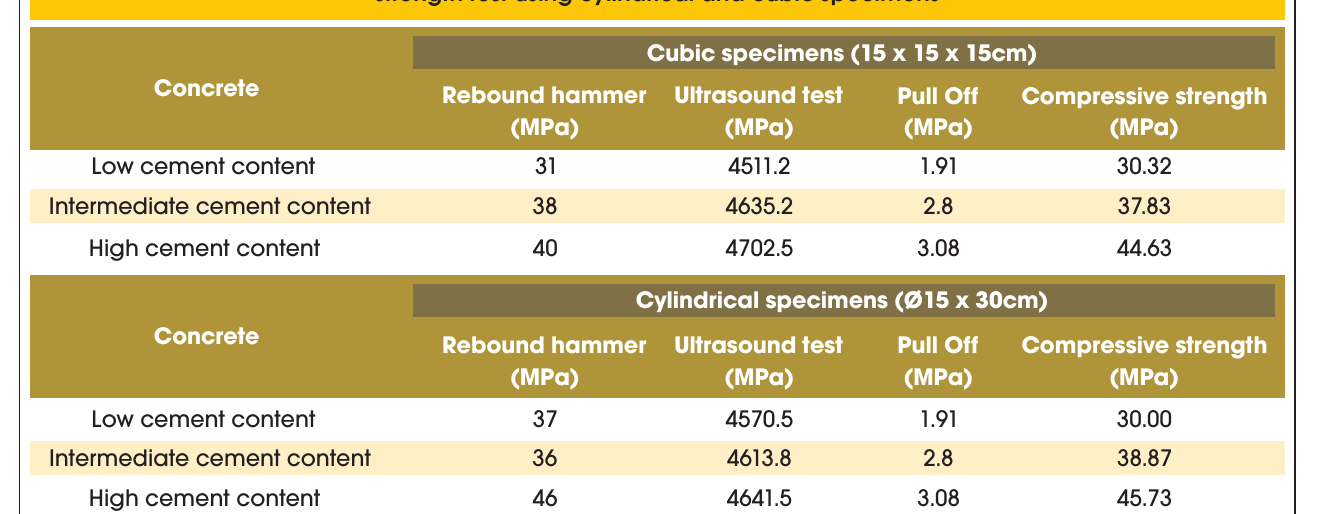
Table 3 – Gathered data in non-destructive tests and compressive strength test using cylindrical and cubic